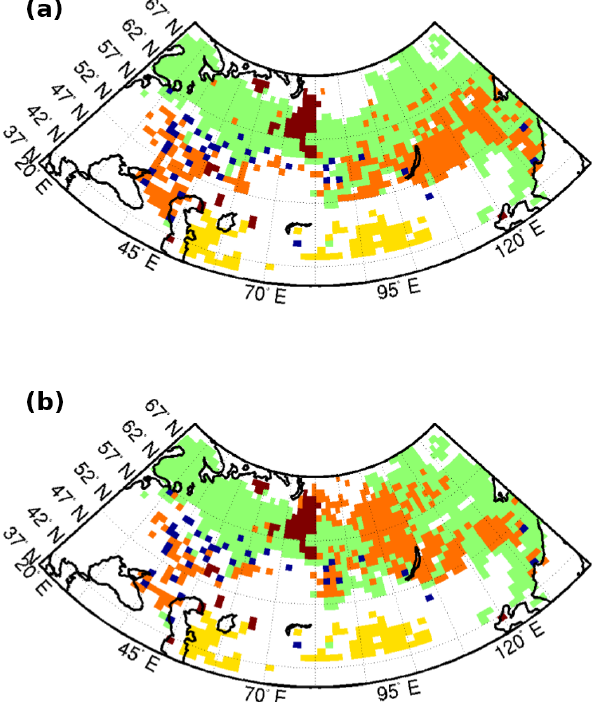
Figure 5. Map of the 2015 (a) and 2016 (b) aerosol sources coupled with a FLEXPART PES gridded map: grid cells with large cities (blue square), central Asia desert (yellow), biomass burning (light brown), gas flaring (dark brown) and taiga